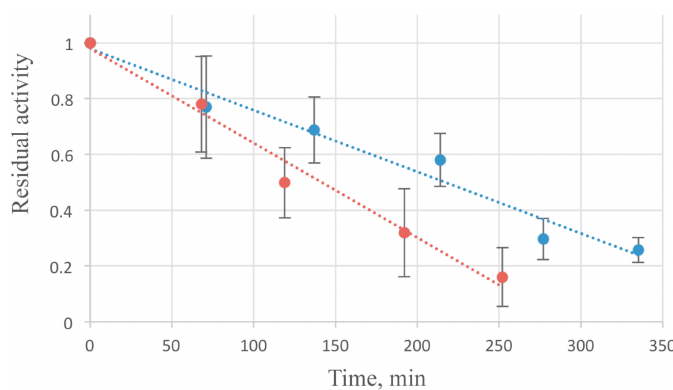
Figure 4. AcLys thermal inactivation kinetics at 37 ◦ C. The substrate E. coli CR63 were washed with deionized water and frozen at − 70 ◦ C. AcLys stock in 20 mM Bis-Tris (pH 6.0) with the addition of 10 mM NaCl (red), or 300 mM NaCl (blue) was incubated at 37 ◦ C for indicated time periods, then the enzyme was added to the standard reaction mixture to 1 µ g/mL concentration, and the reaction ran at 25 ◦ C.